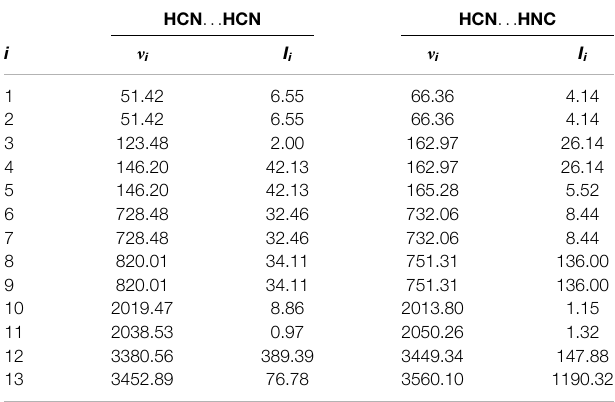
TABLE 1 | Harmonic frequencies ( ] i , in cm − 1 ) and infrared intensities ( I i , in km/mol) for vibrational normal modes i of HCN ... HCN and HCN ... HNC complexes computed at the MP2/aug-cc-pVTZ level of theory.